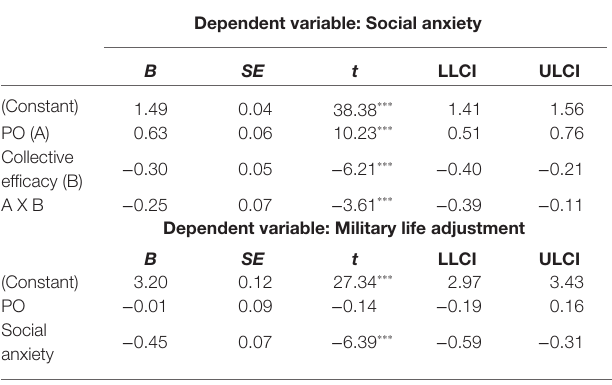
TABLE 5 | Moderated mediation effect of collective